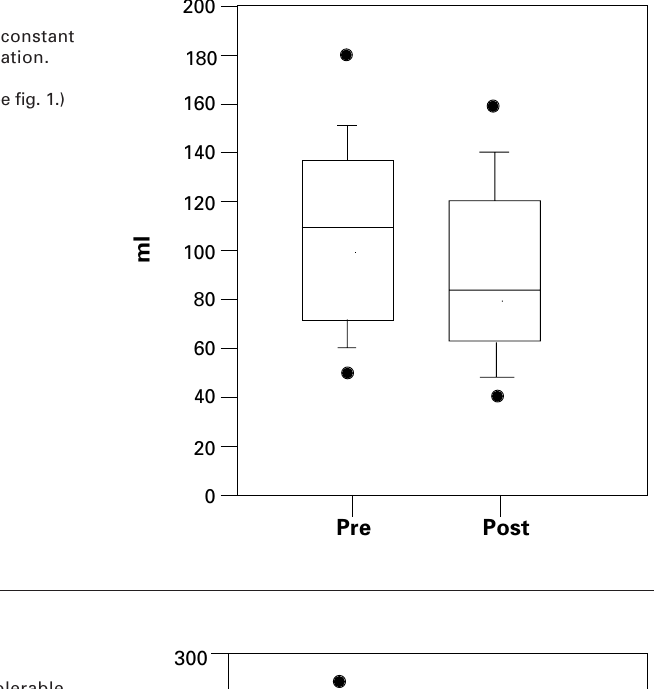
Maximal tolerable